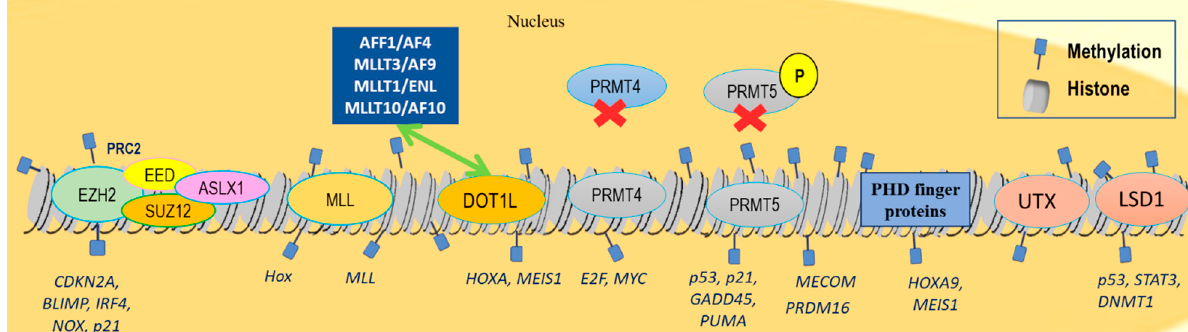
Figure 1. Chromatin landscape indicating histone methylation changes related to hematological malignancies. EZH2 methyltransferase regulates the differentiation, proliferation, and apoptosis of the adult hematopoietic stem cells by repressing CDKN2A , BLIMP , and IRF4 , as well as pro- apoptotic genes, NOX and p21 . EZH2 overexpression or gain-of-function mutations have been detected in high-grade follicular lymphoma, DLBCL, and NKT lymphomas. Loss-of-function EZH2 mutations have been observed in MDSs, atypical CML, myelofibrosis, and T-ALL. Mutations in other PRC2 members, such as EED, and SUZ12, have been observed in some MDS and T-ALL cases, whereas ASXL1 mutations promote myeloid transformation through loss of PRC2-mediated gene repression. Frequent MLL1 translocations have been detected in AML and ALL. Most common fusion partners accounting for approximately 80% of MLL rearrangements are AFF1/AF4, MLLT3/AF9, MLLT1/ENL, and MLLT10/AF10, which interact with DOT1L that further sustains the expression of key pro-leukemic genes HOXA and MEIS1 . PRMT4 knockdown inhibits cell-cycle progression and promotes apoptosis by downregulating E2F and MYC target genes in leukemic cell lines. PRMT5 is overexpressed in DLBCL and MCL via regulation of p5 , p21 , GADD45 , and PUMA genes. MECOM and PRDM16 are rearranged in AML. PHD finger proteins recognize lysine methylation, upregulating HOXA9 and MEIS1 gene activity in AML. Lysine demethylase UTX is also frequently mutated in MM and ALL, and LSD1 is overexpressed in ALL, AML, CML, MPNs, and MDSs, repressing p53 , STAT3 , and DNMT1 activity.